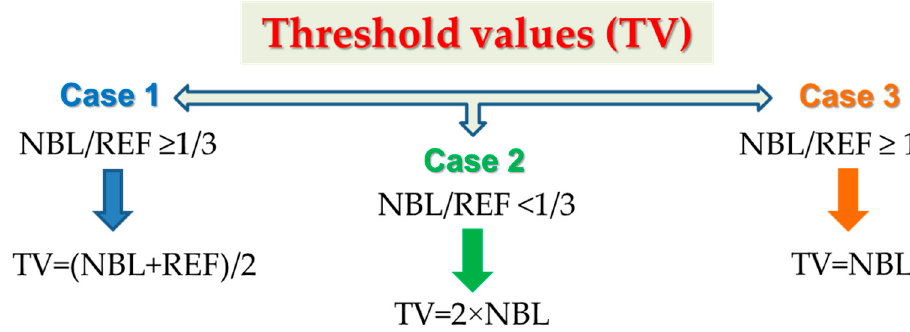
Figure 5. Flow chart for the assessment TVs for the target parameter.